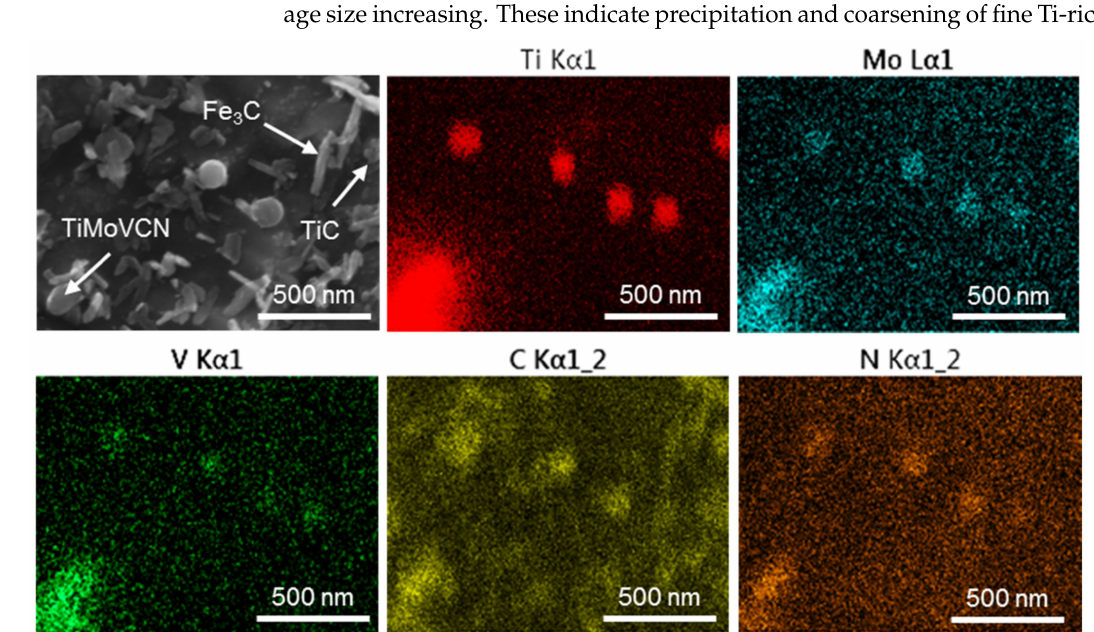
Figure 8. SEM-EDS maps of fine particles observed in both steel grades.